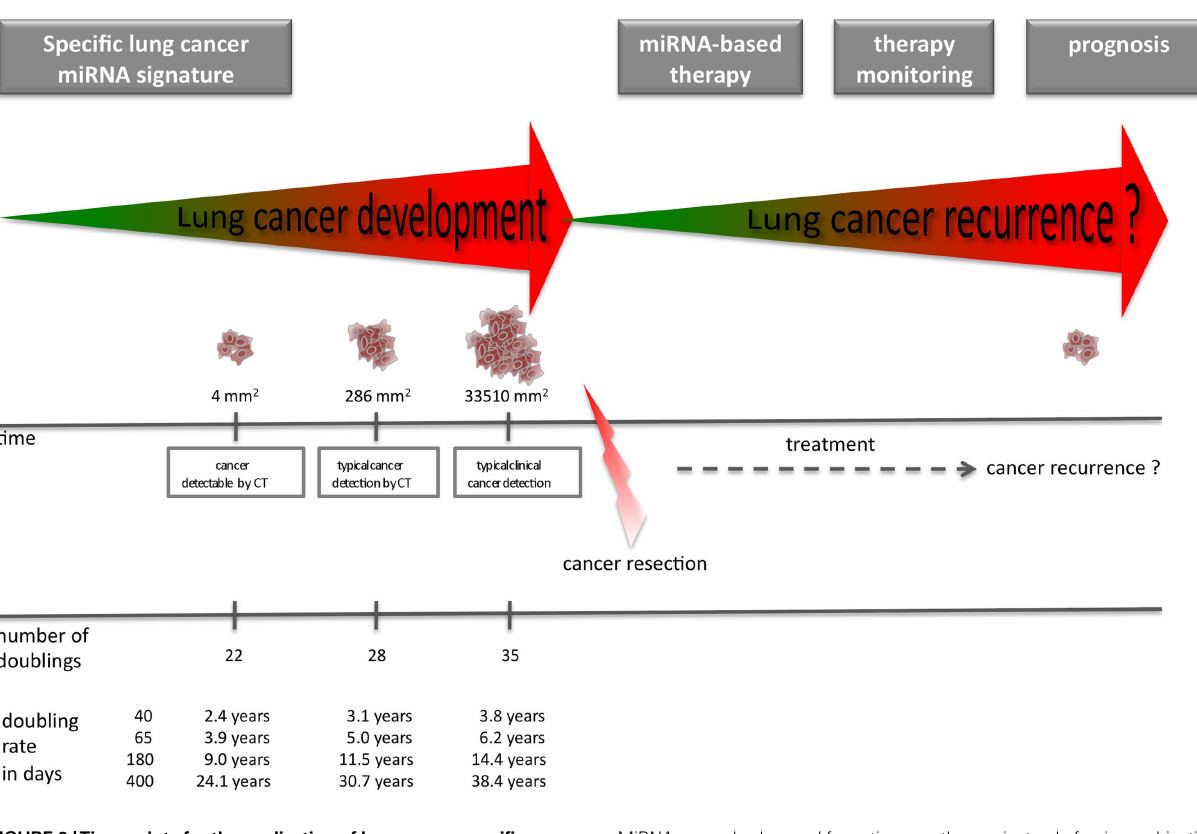
MiRNAs may also be used for anti-cancer therapy instead of or in combination with radiotherapy or chemotherapy.The timeline at the bottom of the Figure shows the growths rate of a lung tumor with several doubling rates (adapted from Bach et al.,